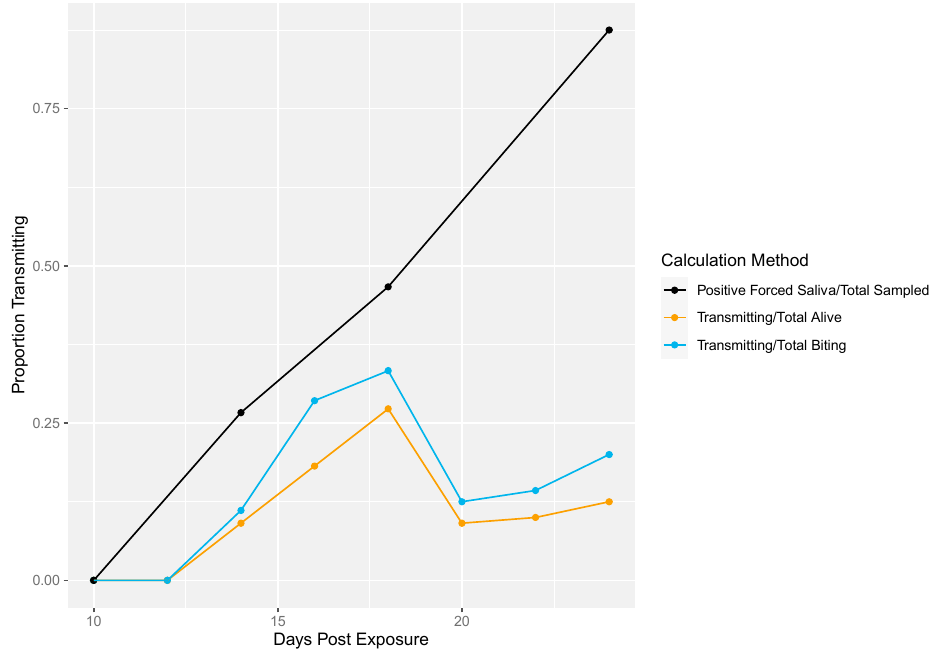
Figure 4. Rockefeller transmission profile. Traditional vector competence was calculated as the proportion of mosquitoes with positive forced saliva samples divided by the number sampled (black line). From the longitudinal sampling method, the total number of transmitting mosquitoes over the total number of living mosquitoes was calculated per sampling day (yellow line). Lastly, the total number of transmitting mosquitoes over the total number of mosquitoes that bit was calculated per sampling day (blue line).